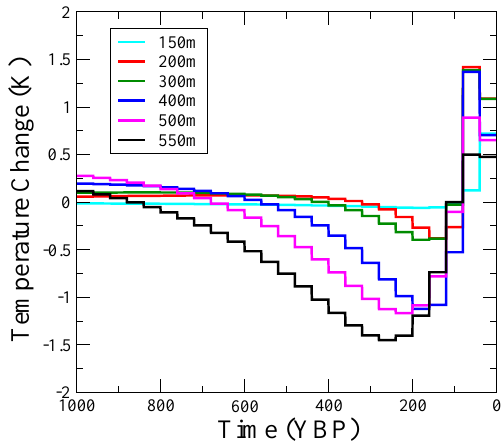
Fig. 9. Ground surface temperature histories estimated from inver- sions of the temperature anomalies shown in Fig. 8. Estimates of the error on the inversion parameters are not shown for clarity, but they are small because of the eigenvalue cutoff used to regularize the